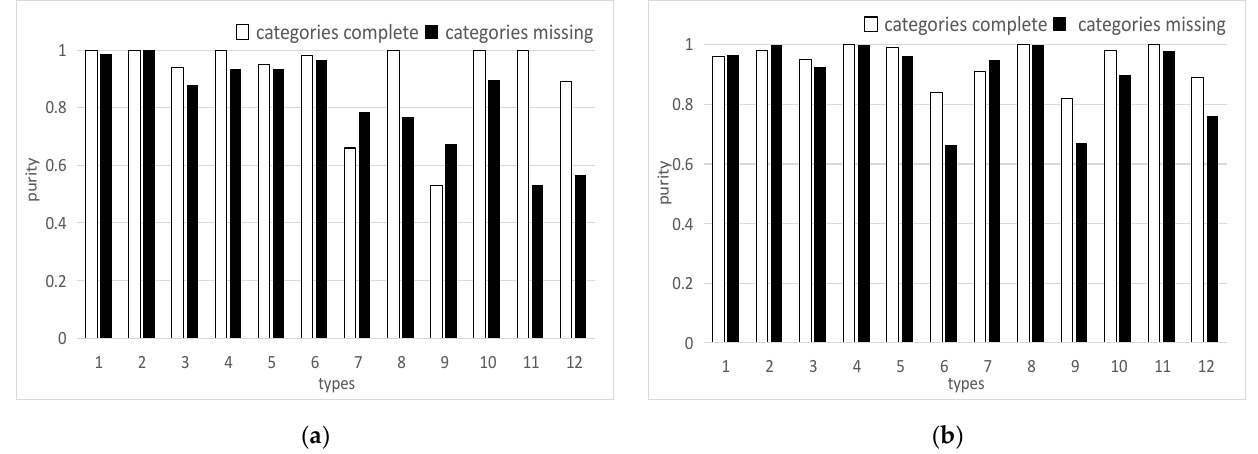
Figure 13. Classification accuracy of various types of data. ( a ) Directly Trained model; ( b ) two-stage